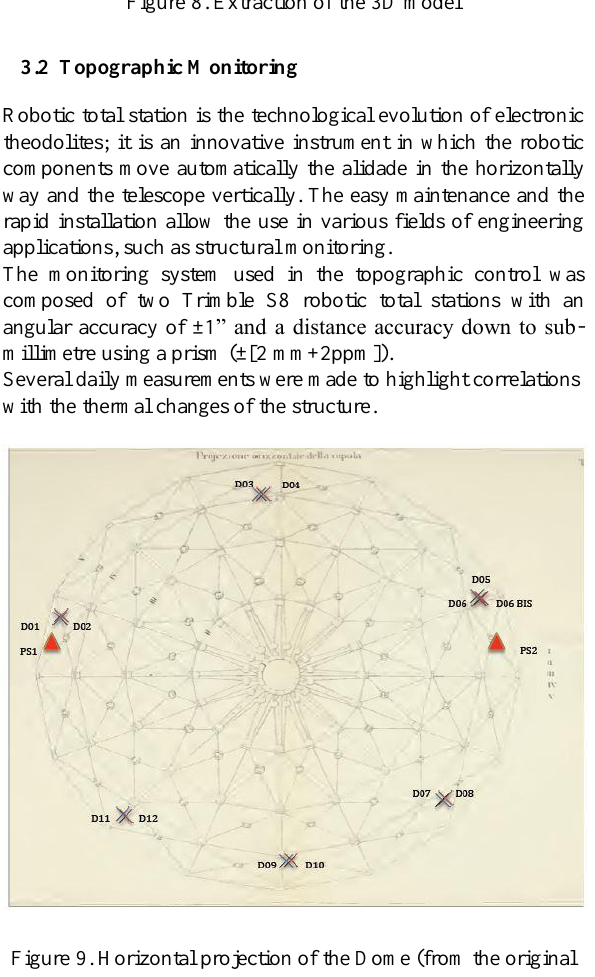
Figure 7. Detail of the point cloud of the stage